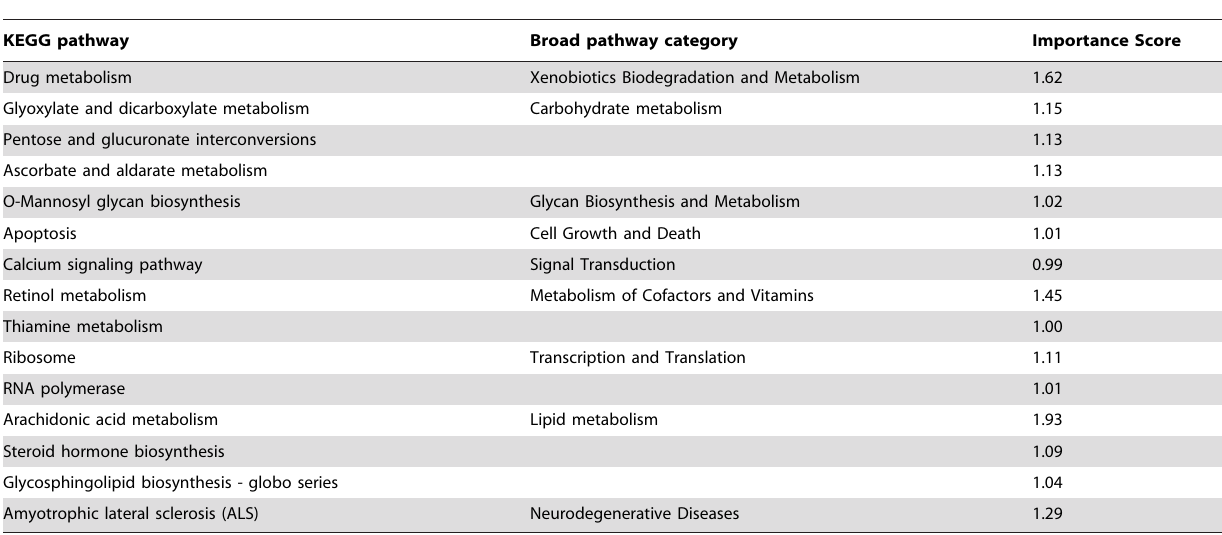
Table 5. Top 15 pathways of the fitted prediction